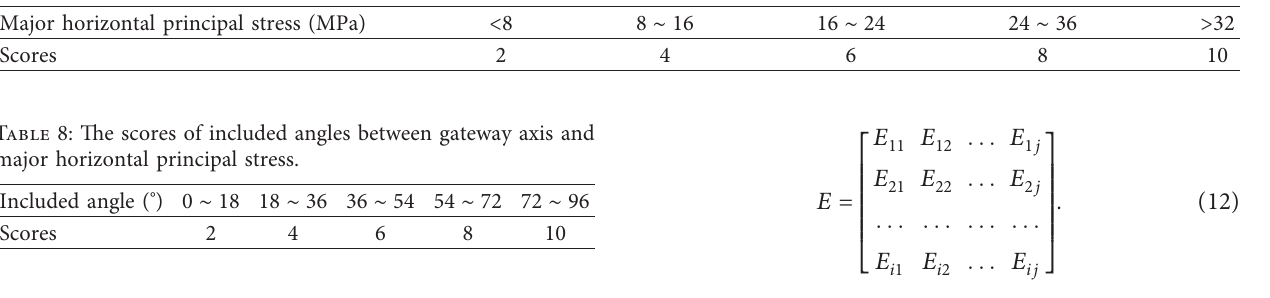
Table 9: The scores of width of protective pillar in the current coal seam.